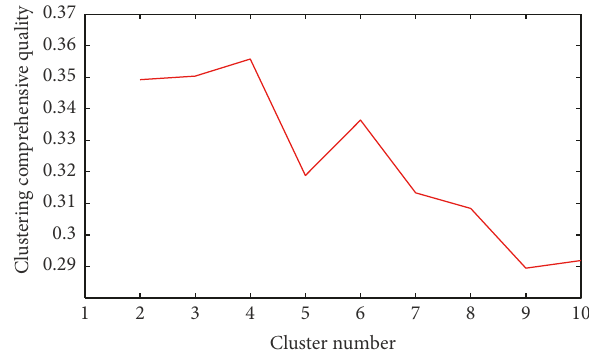
Figure 1: Clustering comprehensive